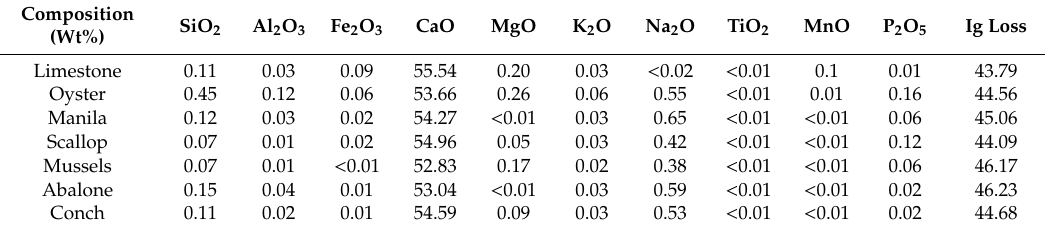
Table 1. XRF analysis of the di ff erent mollusk shells with natural